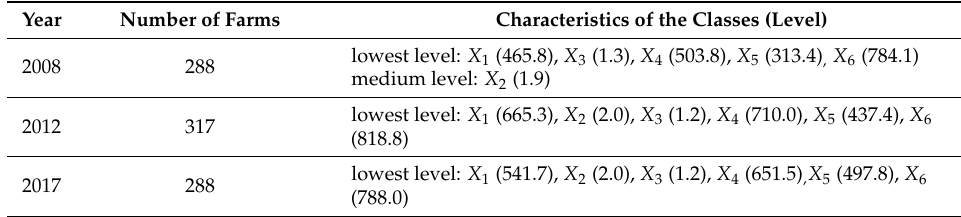
Table 5. Characteristics of farms in the type two group.